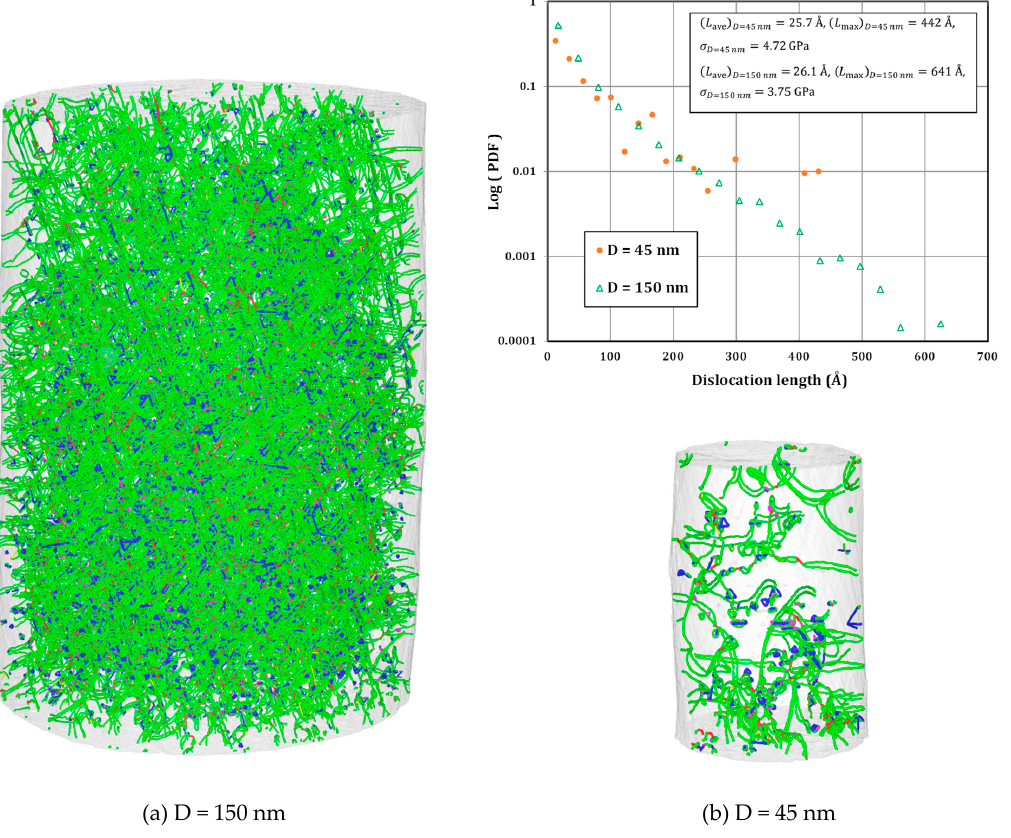
Figure 25. The dislocation network at the strain of ε = 0.2 subjected to the strain rate of ε = 3.33 × 10 8 s − 1 and pillar diameters of: ( a ) D = 150 nm; ( b ) D = 45 nm (after Voyiadjis and Yaghoobi [16]).